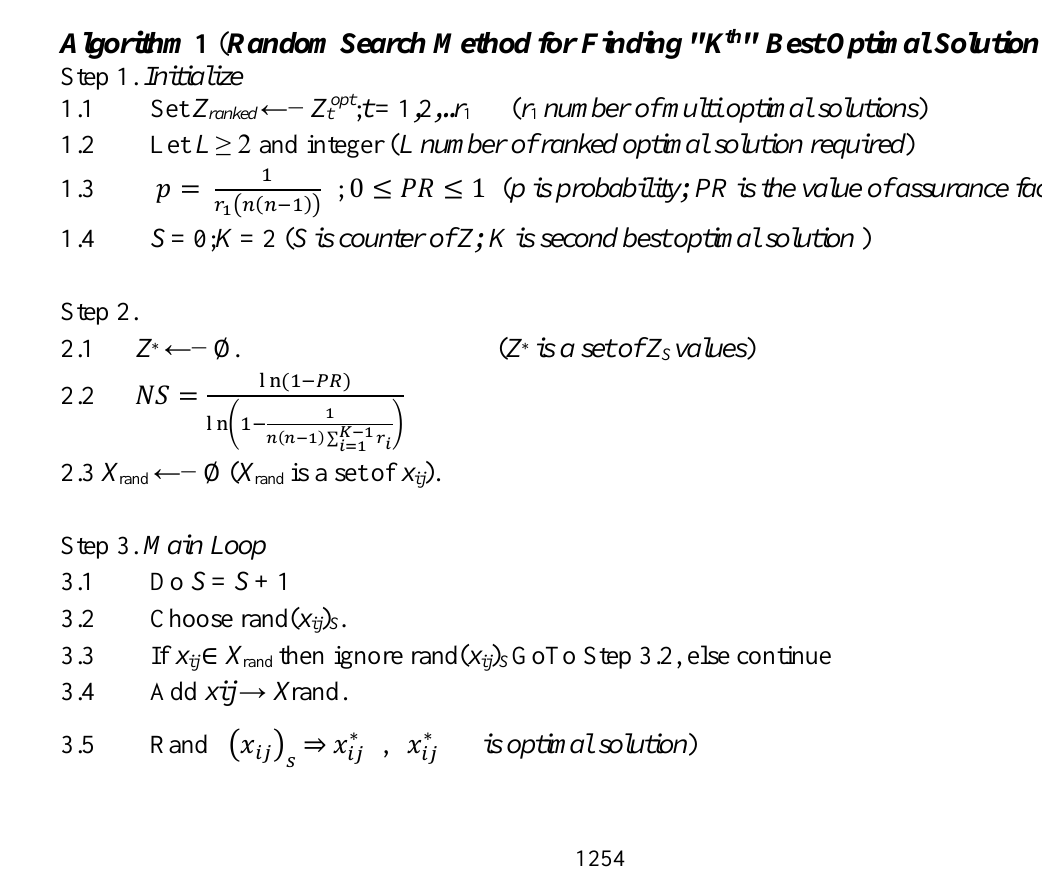
Algorithm 1 ( Random Search Method for Finding "K th " Best Optimal Solution